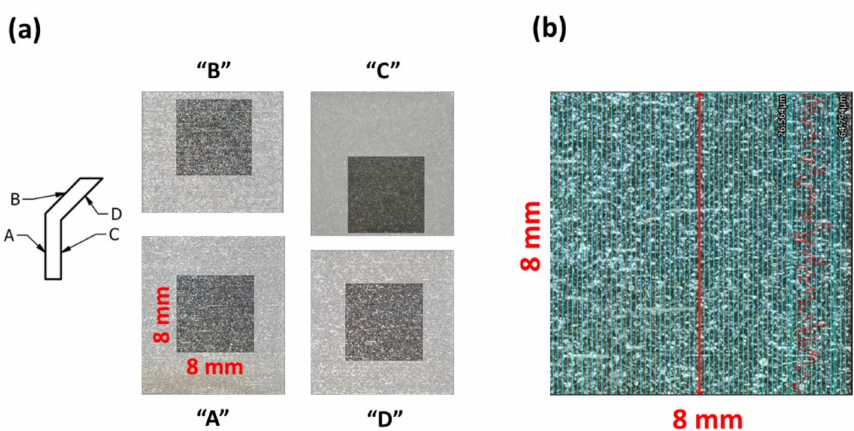
Figure 6. V-shape, Ra measurements: ( a ) segments studied on each of the surfaces A, B, C and D; ( b ) cropped 8 × 8 mm segment with measuring lines.